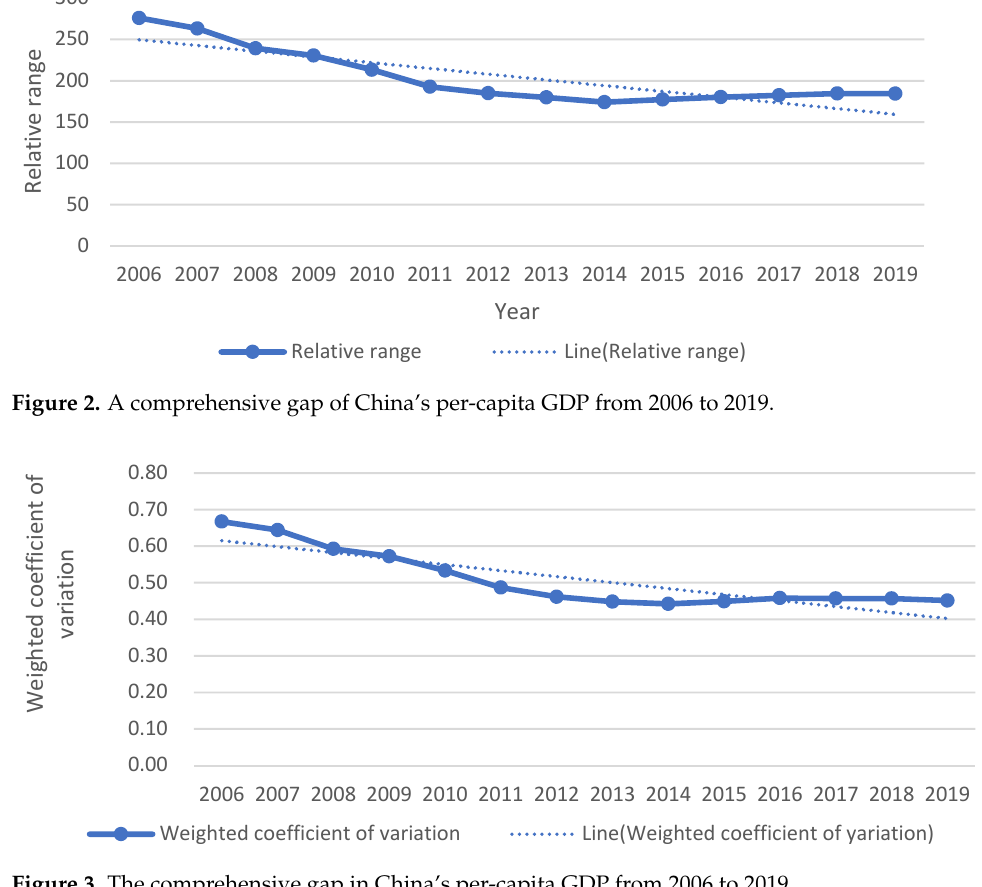
Figure 2. A comprehensive gap of China’s per-capita GDP from 2006 to 2019.